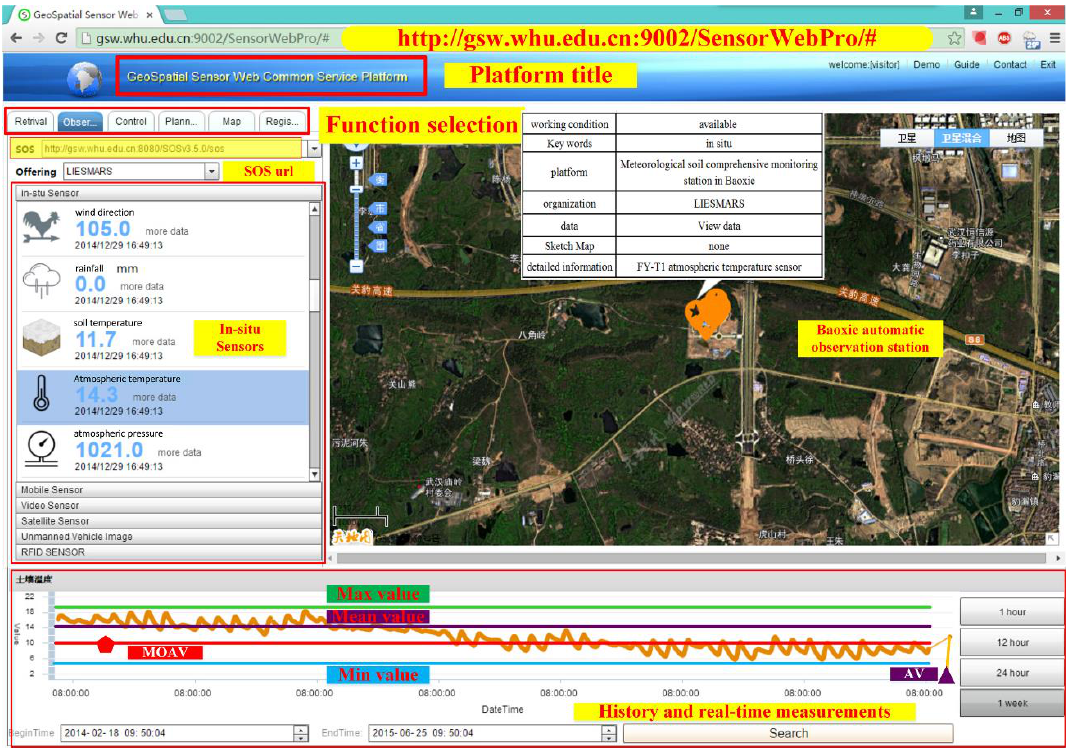
Figure 8. The Geospatial Sensor Web Common Service Platform and the visualization of SM and meteorological observations based on the proposed CESCI.